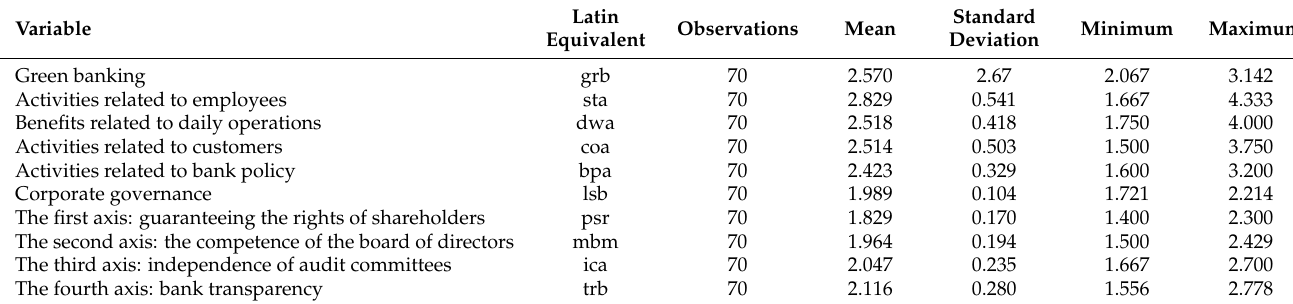
Table 7. The Descriptive statistics of hidden research